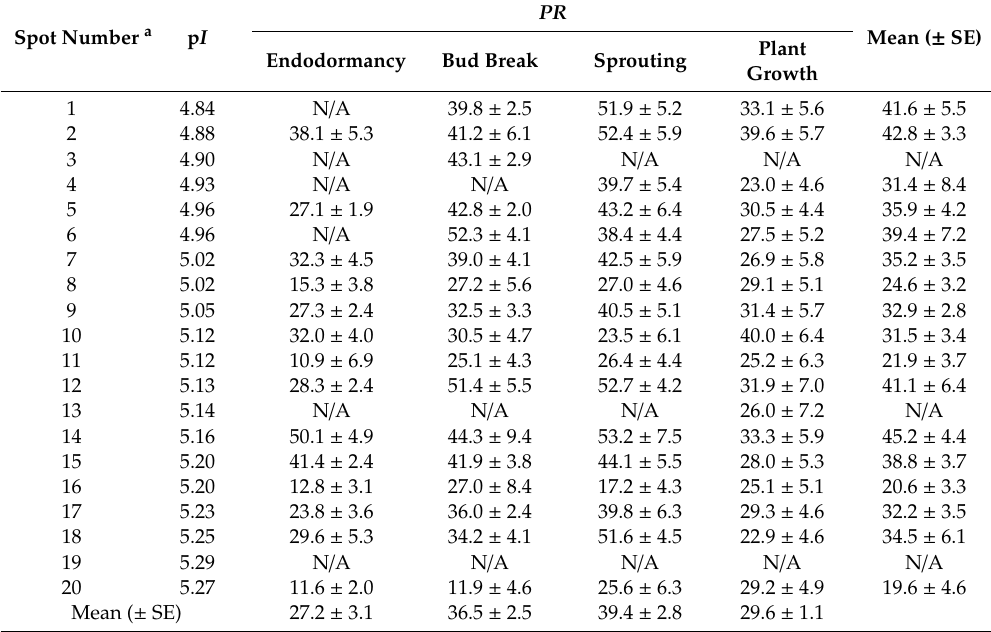
Table 1. Mean ( ± SE) phosphorylation rate ( PR ) of patatin spots in di ff erent stages of potato tuber (Kennebec cultivar) life